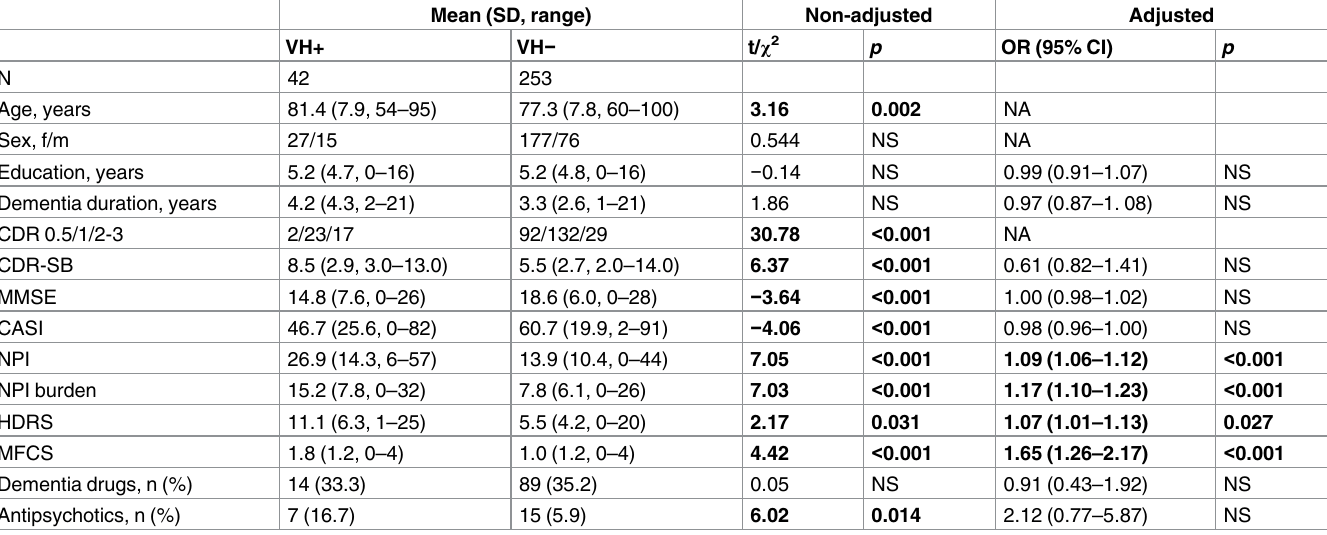
Table 1. Demographic and background characteristics of patients with Alzheimer’s disease (AD) with or without visual hallucinations (VHs). Mean (SD, range)